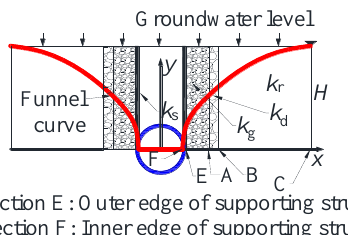
Figure 3. Tunnel drainage calculation model.